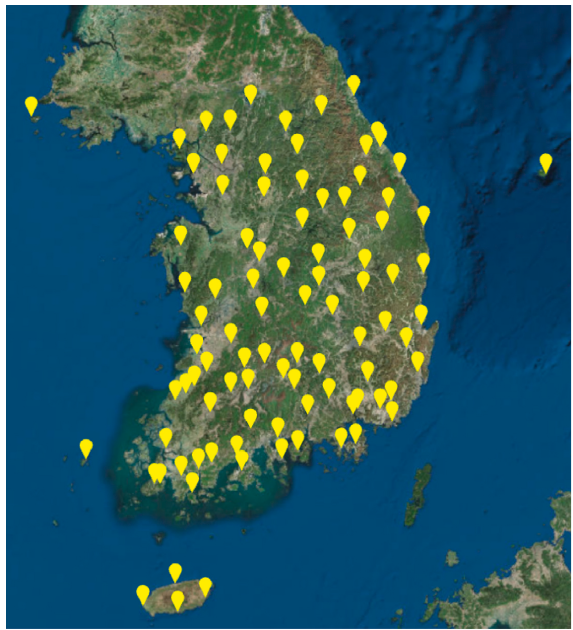
Figure 1: Distribution of ASOS locations over South